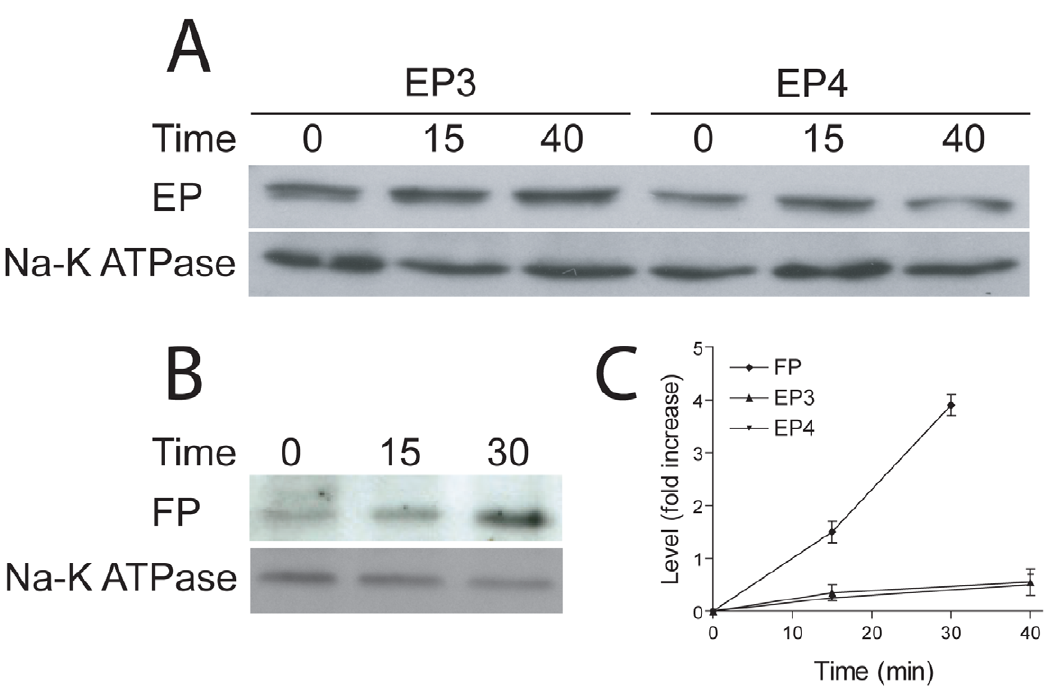
Figure 10. Hydrogen peroxide treatment augments surface levels of some, but not all, prostanoid receptors. Panels A and B: HA- tagged EP3, EP4 and FP transiently transfected into HEK293 cells, and surface levels quantitated by derivatizing with a water-soluble biotin analogue and recovered with streptavidin beads following challenge with 10 m M hydrogen peroxide. The Na + -K + ATPase is used in all cases as a loading control. Panel C: Quantitation from two similar experiments for surface levels of EP2, EP3 and FP. There is a clear increase in FP levels, but not for EP2 or EP3.